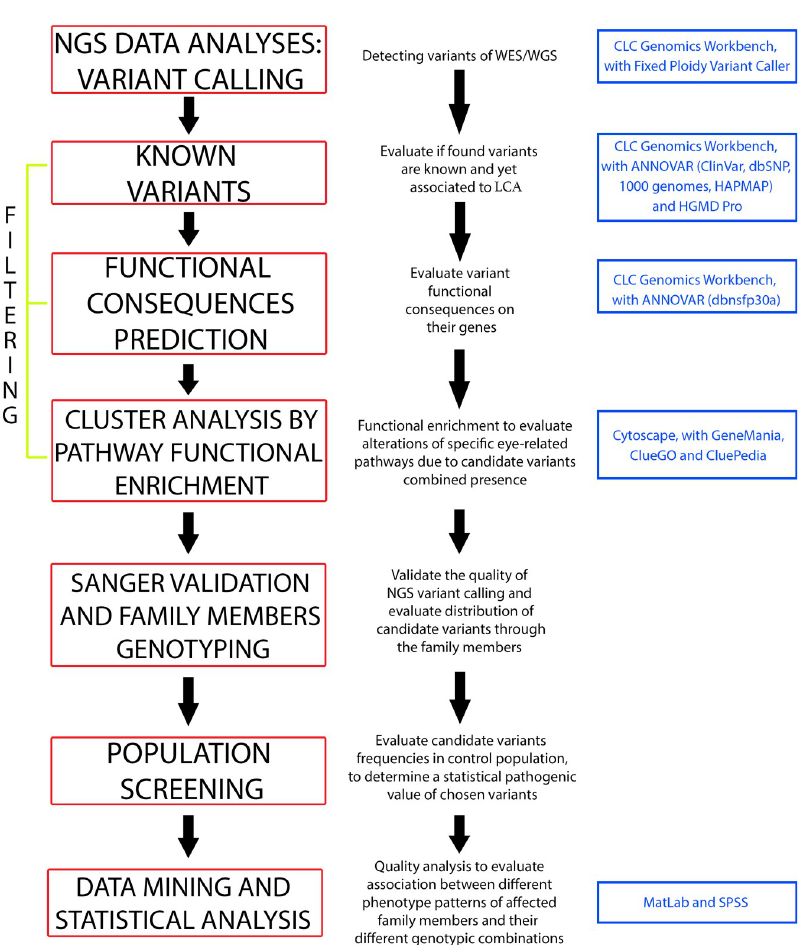
Fig 3. Graphical workflow of data analyses. Data analyses involved several filtering levels, to obtain final candidate variants.